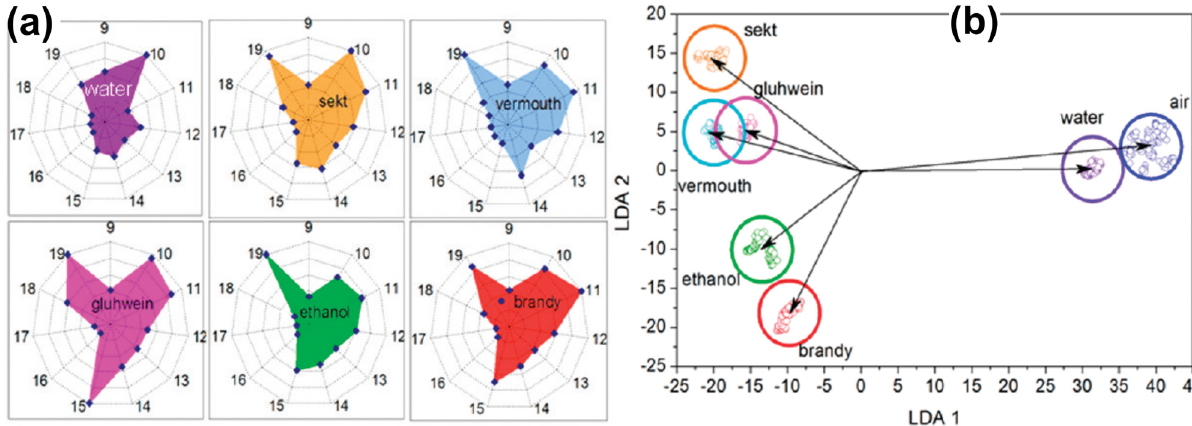
Figure 9: ( a ) Polar plots with the responses of the sensors in the array to the aroma of various alcoholic beverages. ( b ) Corresponding LDA plot of the sensor array to the beverages aromas. Reprinted with permission from ref. [ 58 ] .